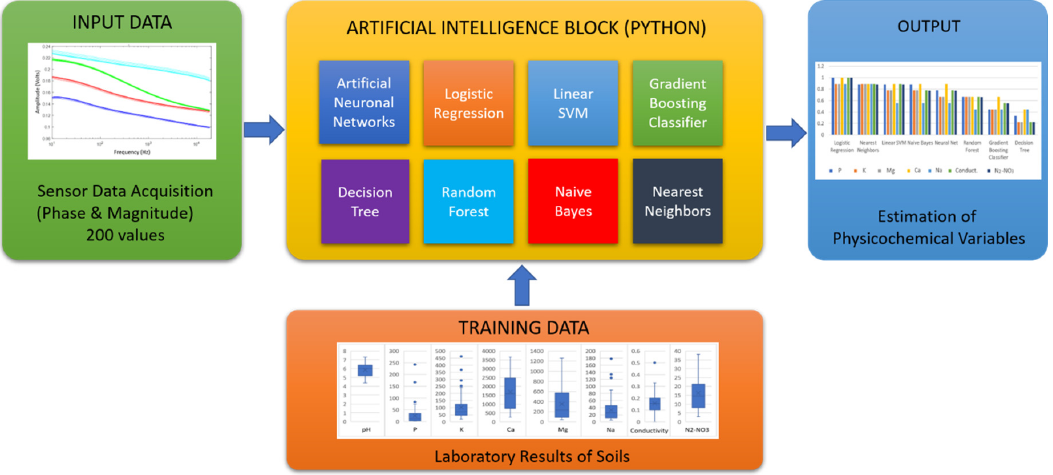
Figure 7. Determining psychochemical properties of soil using artificial intelligence (AI) algorithms and the sensor data.